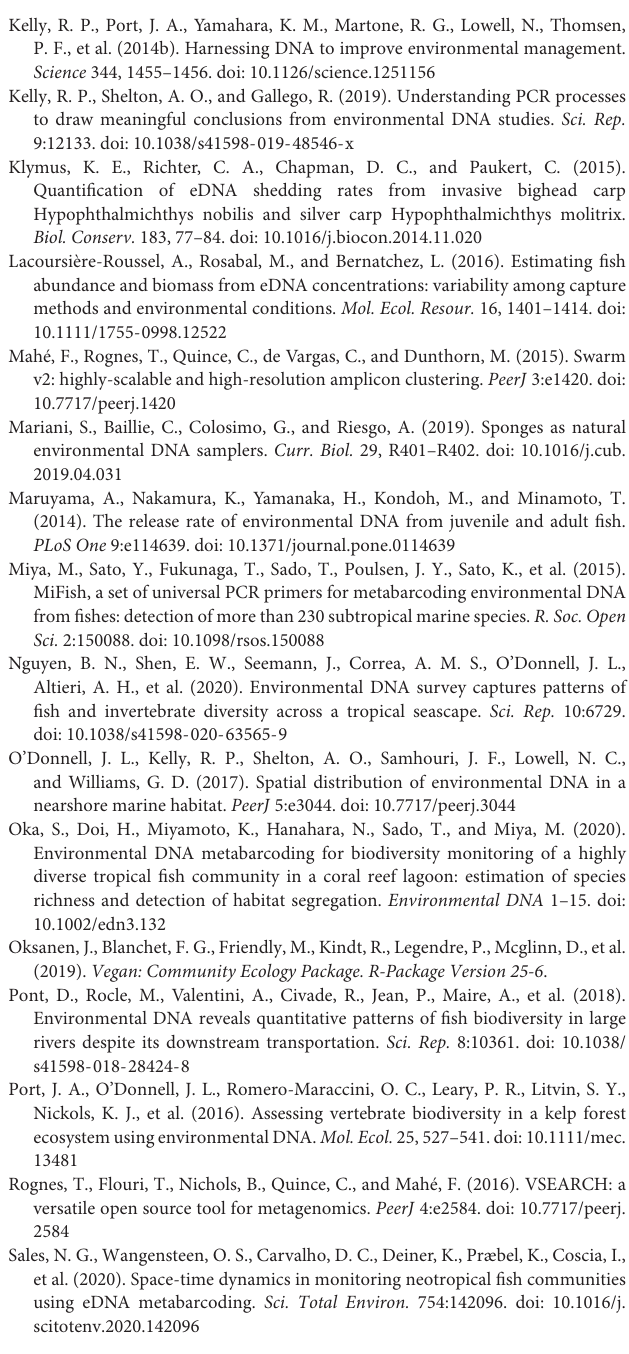
samples are based on Bray-Curtis distances. Scale bar represents the relative abundance of the fish MOTUs in each sample. Supplementary Figure 6 | Cluster dendrogram based on Jaccard distances of fish communities recovered from sponge nsDNA. Sample replicates pooled together. Supplementary Figure 7 | Mean reads per MOTU of the studied fish features: (A) Aggregation behavior, (B) Individual size, (C) Depth range, (D) Habitat, and (E) Migration. (F) Names of the fish species recovered from sponge nsDNA sized according to their number of